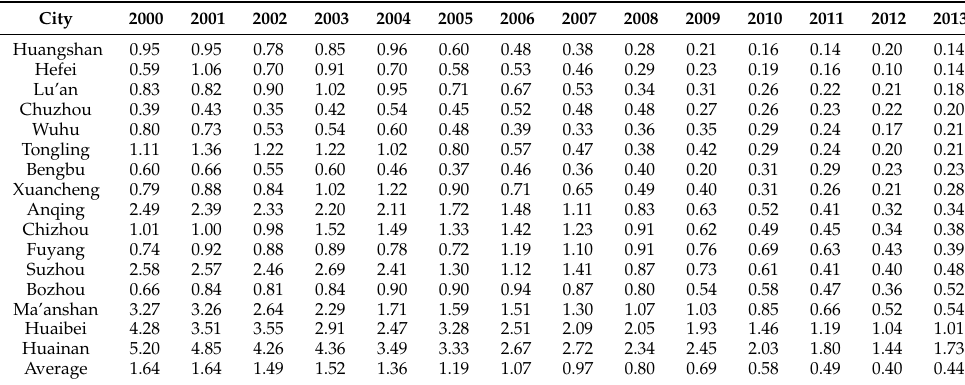
Table 3. Changes in the ICEI of prefecture-level cities in Anhui Province from 2000 to 2013. Unit: ton/ ten thousand yuan .